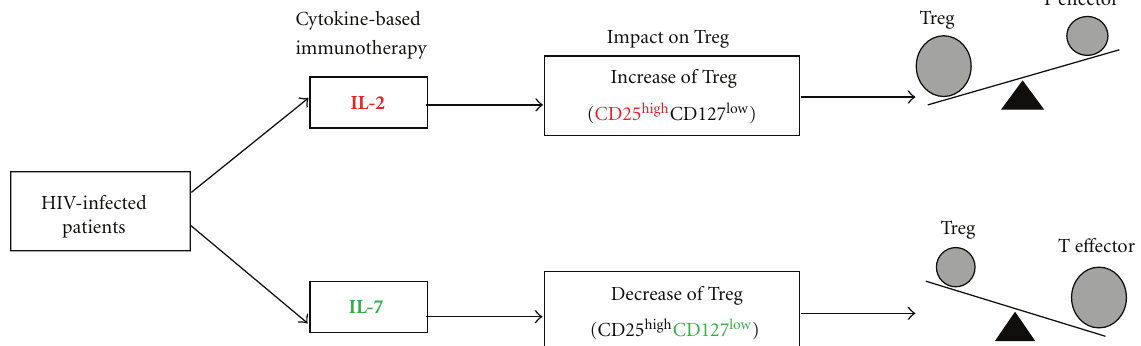
Figure 2: The impact of cytokine-based immunotherapy on Treg in HIV infection. The IL-2 immunotherapy results predominantly in the expansion of Treg, which express high levels of the IL-2 receptor chain CD25. In contrast, IL-7 immunotherapy may preferentially favour the e ff ector T cell population without inducing Tregs because Tregs express low levels of the IL-7 receptor chain CD127.